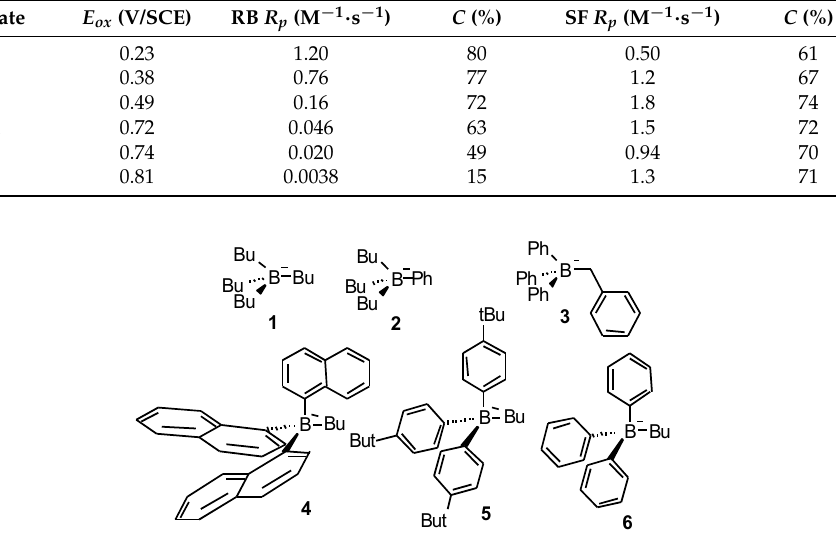
Table 1. Oxidation potentials E ox , rates of polymerization R p and final conversions C of the borate salts used in the photo-polymerizing resin with Rose Bengal ( RB ) or Safranine O ( SF ) as dye [35]. Borate E ox (V/SCE)